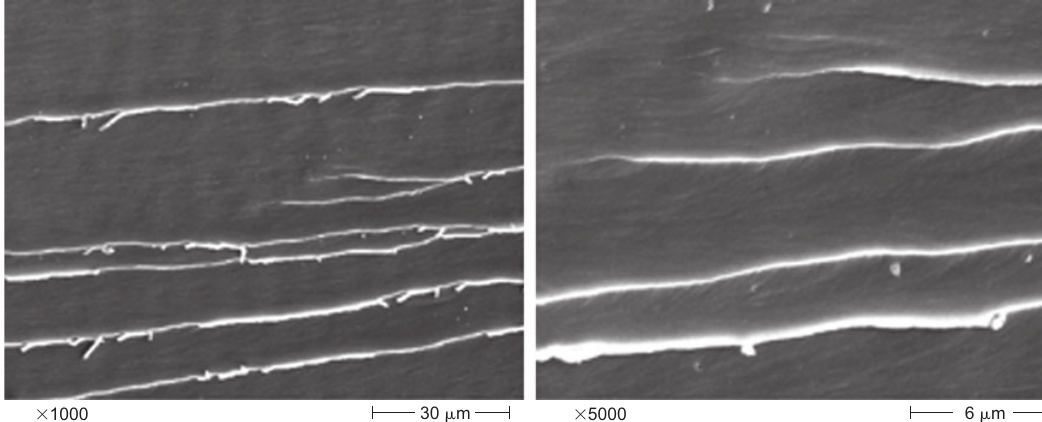
Figure 3 SEM pictures from fracture surface of RTM6 ® + 5 wt % phenoxy.